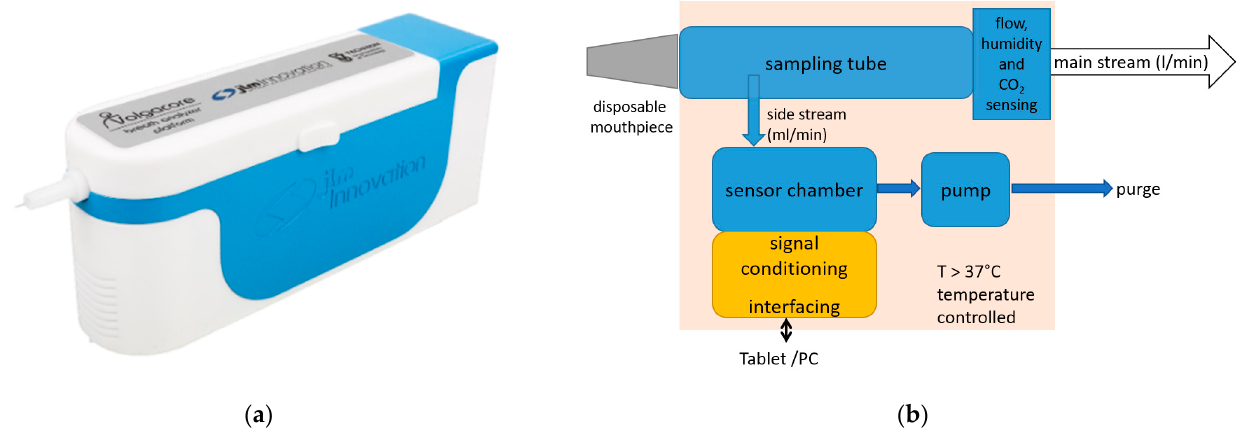
Figure 1. The point-of-care device used in the study: ( a ) the design of the device, with a disposable mouthpiece inserted at the front; ( b ) the main blocks of the system.